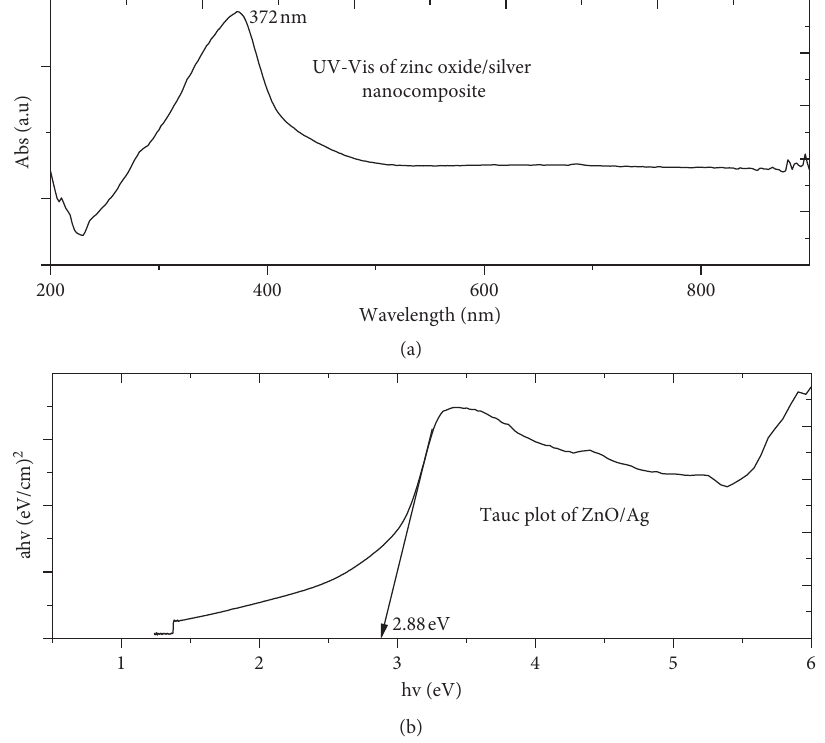
Figure 6: UV-Vis spectra of ZnO/Ag nanocomposite with its equivalent plot showing its energy band